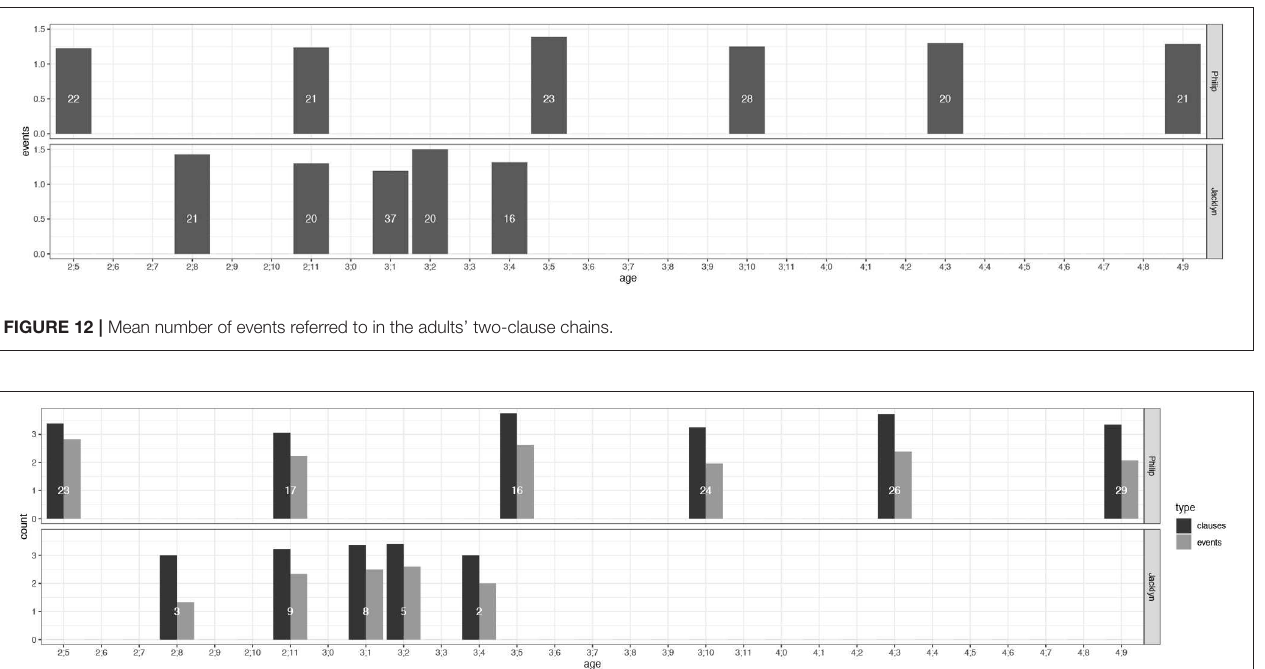
FIGURE 13 | Clauses vs. events in the adults’ clause chains of three clauses or